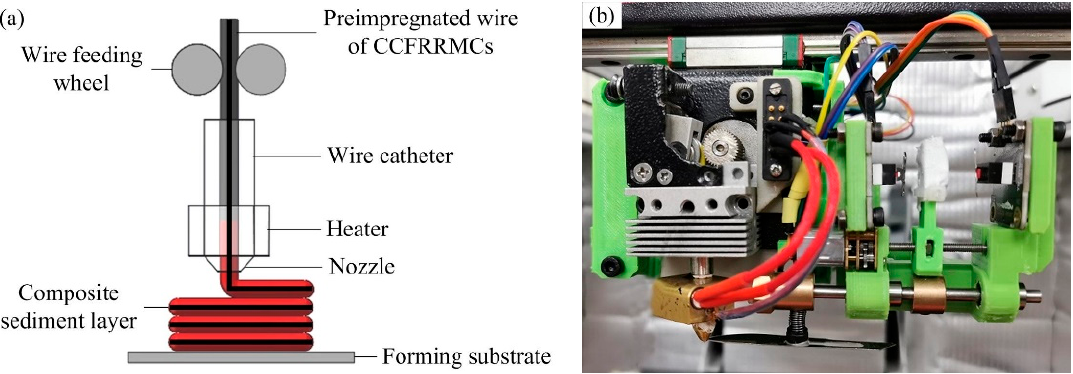
Figure 2. ( a ) Additive manufacturing process for continuous carbon fiber reinforced resin matrix composites; ( b ) the composite wire melting extrusion nozzle.